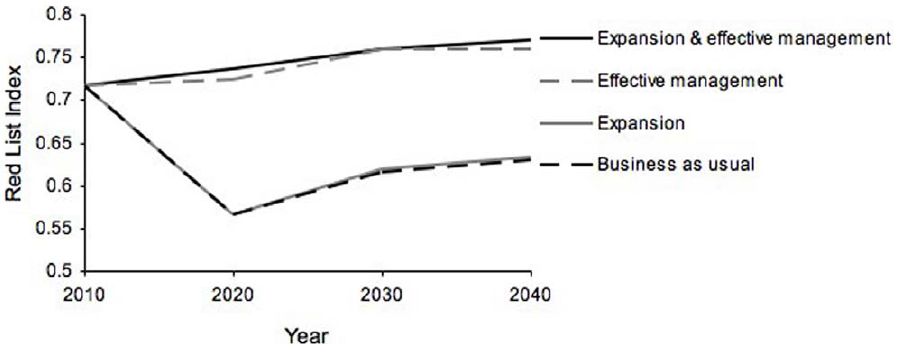
Figure 2. Changes over time in the Red List Index (RLI) under four policy scenarios for protected area management in Africa: 1) business-as-usual, 2) expansion of terrestrial PA network to 17% of each country, 3) improved management effectiveness of PAs, and 4) expansion to 17% with improved management effectiveness. The RLI was calculated for 53 species of large mammals in sub-Saharan Africa; an increase in the RLI means a reduction in the average extinction risk of this set of species.